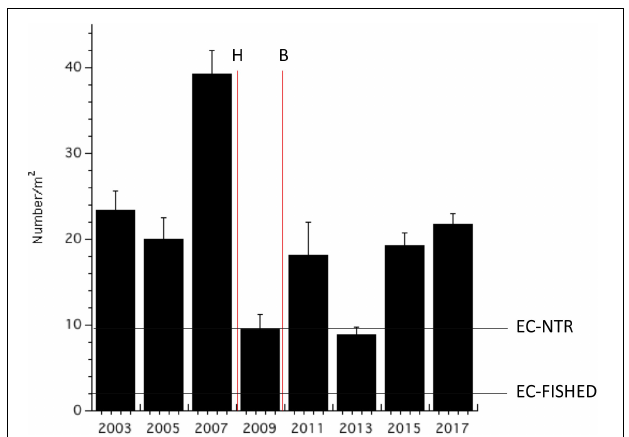
FIGURE 4 | Mean juvenile coral densities from 2003 to 2017 (results are from 316 transects and 1580 quadrats). Vertical lines showing hurricane and bleaching impacts are labeled as in Figure 2 . Note the increase in 2011 was due to recruitment of Agaricia spp. that then grew out of the juvenile size class and contributed to the overall increase in coral